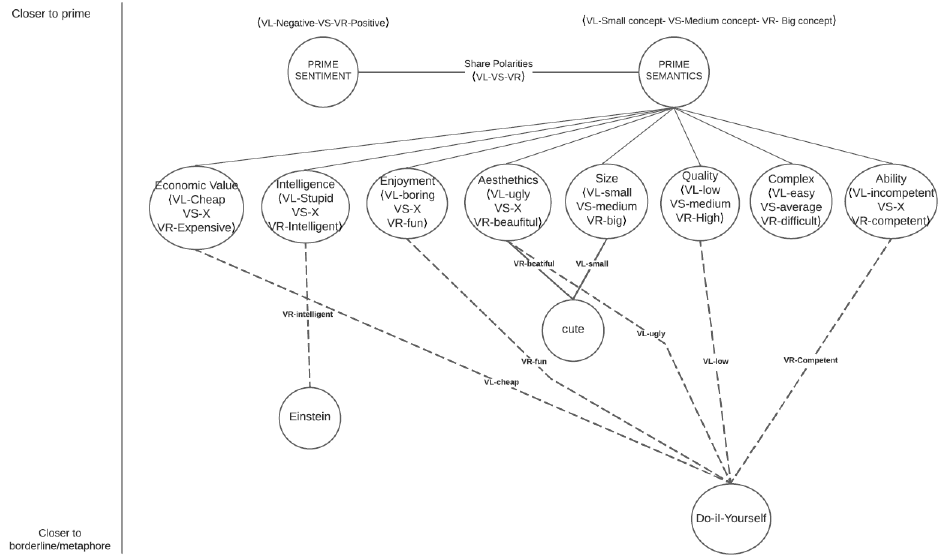
Figure 9. Ontology of evaluative